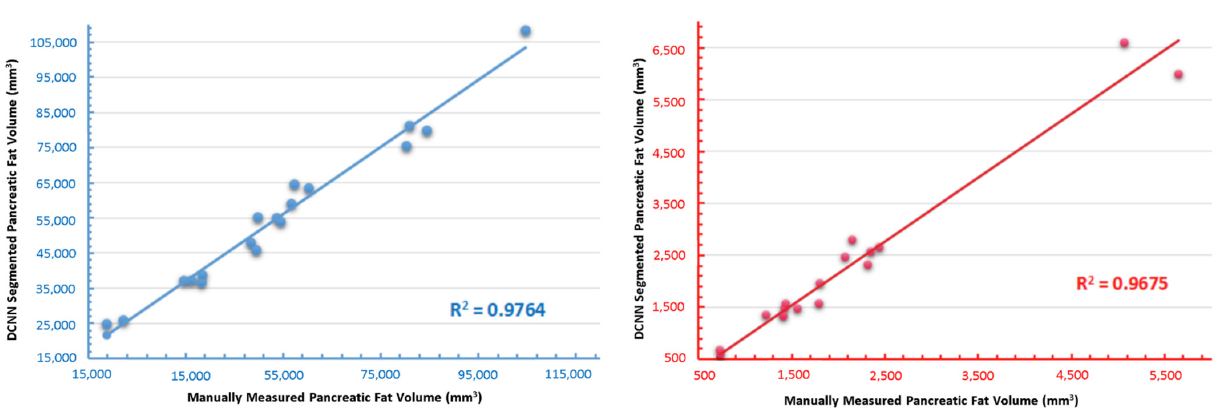
Figure 8. Validation of the integrity of newly trained DCNN. Performance validation measuring pancreas and pancreatic fat volume between expert manual operation and DCNN. The R 2 values were 97.64% and 96.75%, respectively.